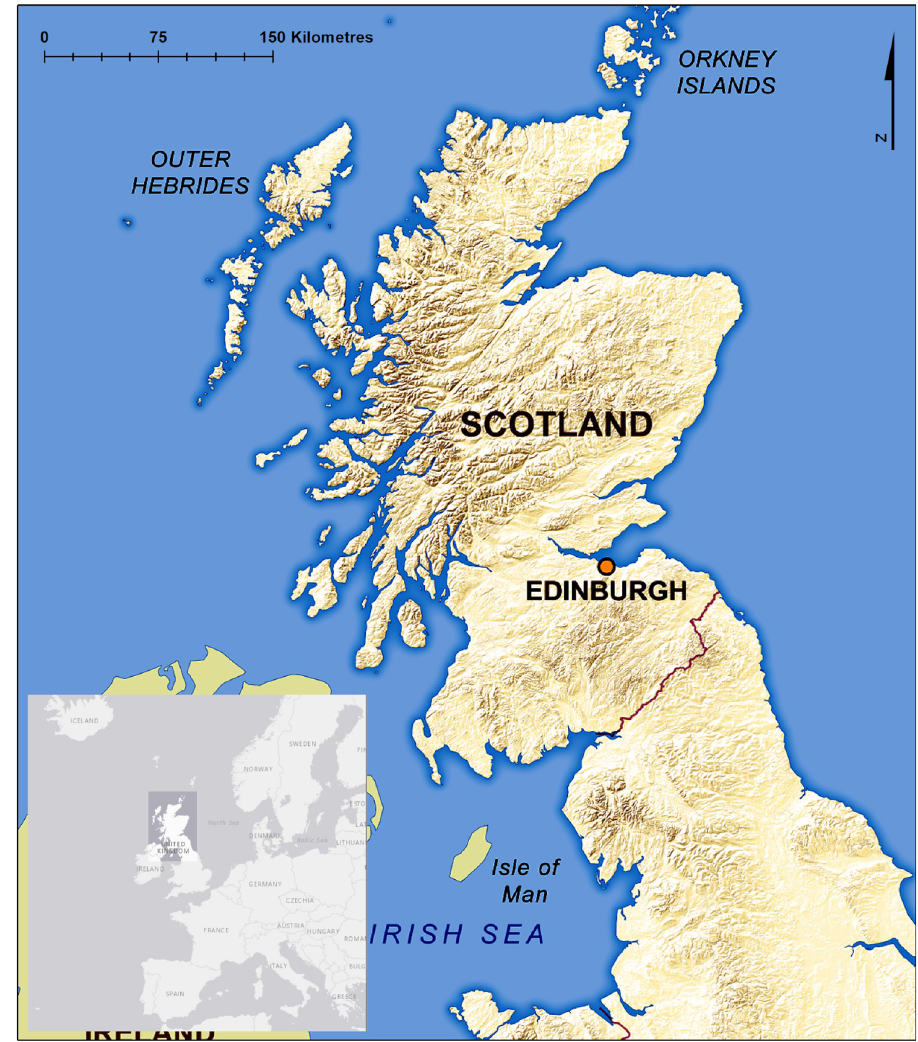
Fig 1. Physical map of Scotland and its location within north-west Europe inset. The mountains of the Highlands/ Grampians in the North, the belt of the Central Lowlands, and the hills of the Southern Uplands can be clearly seen (Ordnance Survey, 2013, © Crown copyright and database rights 2022 Ordnance Survey (100025252); openstreetmap. org, n.d., © OpenStreetMap contributors.).